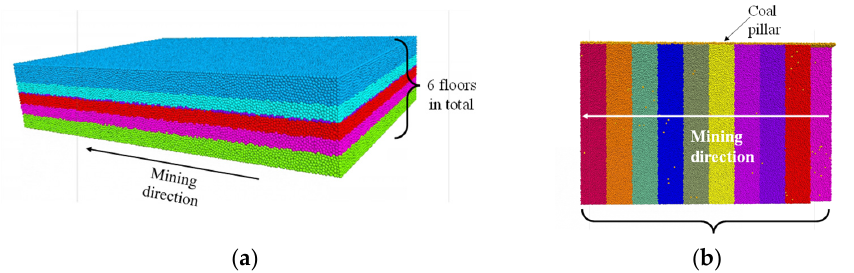
Figure 2. PFC model and caving process of the coal seam model (own elaboration). ( a ) Three ‐ dimensional (3D) numerical model diagram. ( b ) Schematic diagram of caving process.